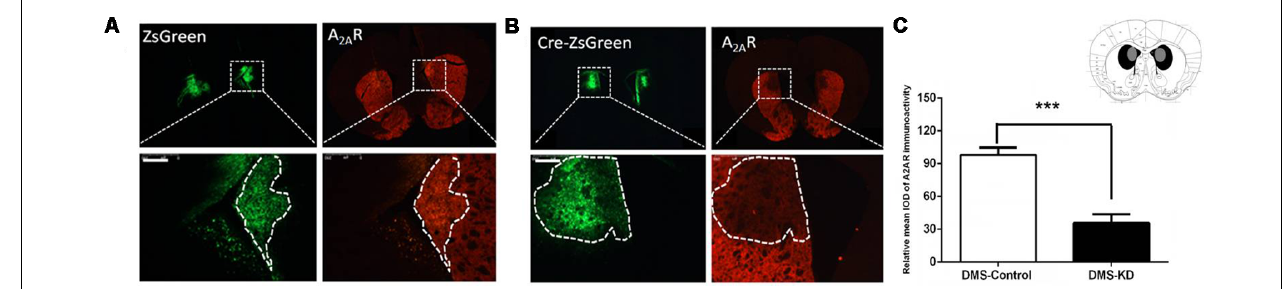
FIGURE 4 | Conditional A 2A R KD in the dorsomedial striatum (DMS) via the Cre-loxP system. (A,B) We employed the same Cre-loxP strategy to selectively knockdown the A 2A R in the DMS by injecting AAV8-CAG-ZsGreen (control virus) or AAV8-CAG-Cre-ZsGreen bilaterally into the DMS of A 2A R flox/flox mice. A 2A R expression (the red fluorescence) was reduced selectively in the Cre-expressing regions of the DMS ( B ; right panels) but not in the control DMS ( A ; right panels). (C) Schematic illustration of the maximal (black) and minimal (gray) A 2A R KD areas in the DMS and optical intensity analysis confirmed that the expression level of A 2A R in the DMS was decreased by 74% compared to the control group. ∗∗∗ p < 0.001.